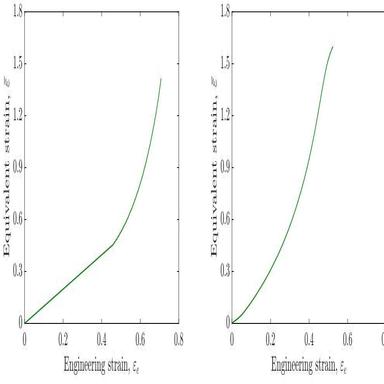
Necking effect correction curves: strain correction (ε¯ - εe) and stress correction (σ¯ - σe).